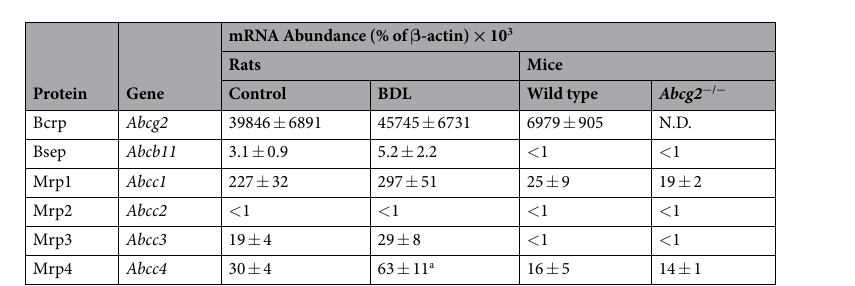
Figure 2. Bile acid concentrations as determined by HPLC-MS/MS in paired samples of serum and milk collected from lactating wild-type (n = 9) ( A–D ) or Abcg2 − / − (n = 12) ( E – H ) mice on day 10 after delivery. Values (means ± SEM) are expressed as individual bile acid species ( A,E ), total bile acids ( B , F ), taurine- conjugated bile acids ( C , G ) and unconjugated bile acids ( D , H ). * p < 0.05, ** p < 0.01, *** p < 0.001, comparing serum and milk by the paired t test.